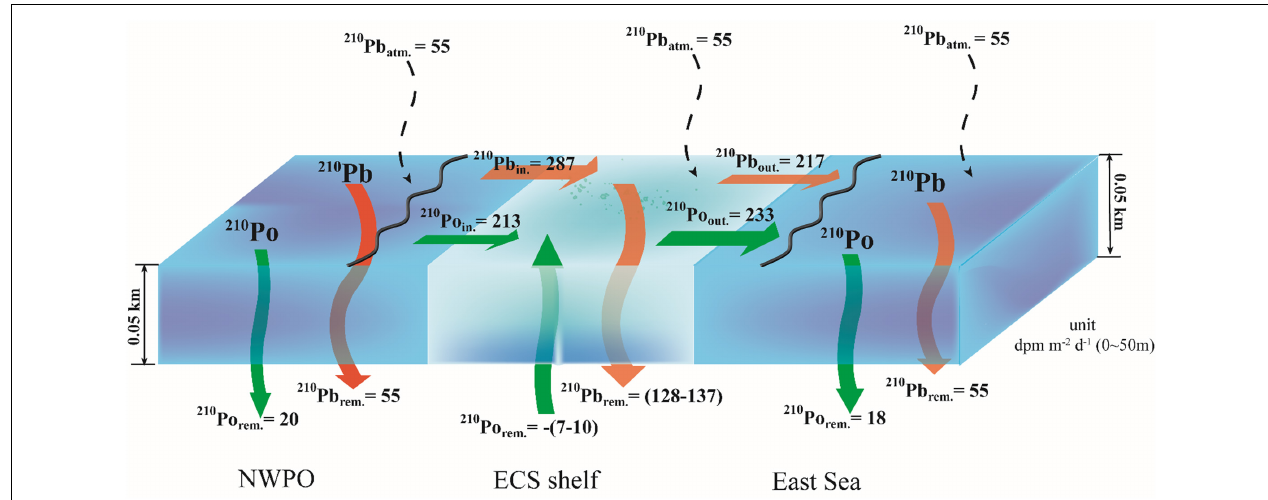
FIGURE 5 | A schematic box model (non-steady-state) of total 210 Pb and 210 Po accounting for the lateral transport of water from the northwestern Pacific Ocean (NWPO) to the East Sea through the East China Sea (ECS) shelf. The uncertainty of each source and sink term accounting for variations in the current velocity and atmospheric input of 210 Pb is below 15%, except for the net input of 210 Po in the ECS shelf water (28%).